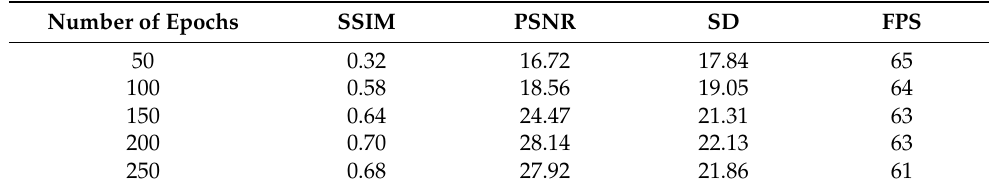
Table 8. The effect of different epoch numbers on the experimental